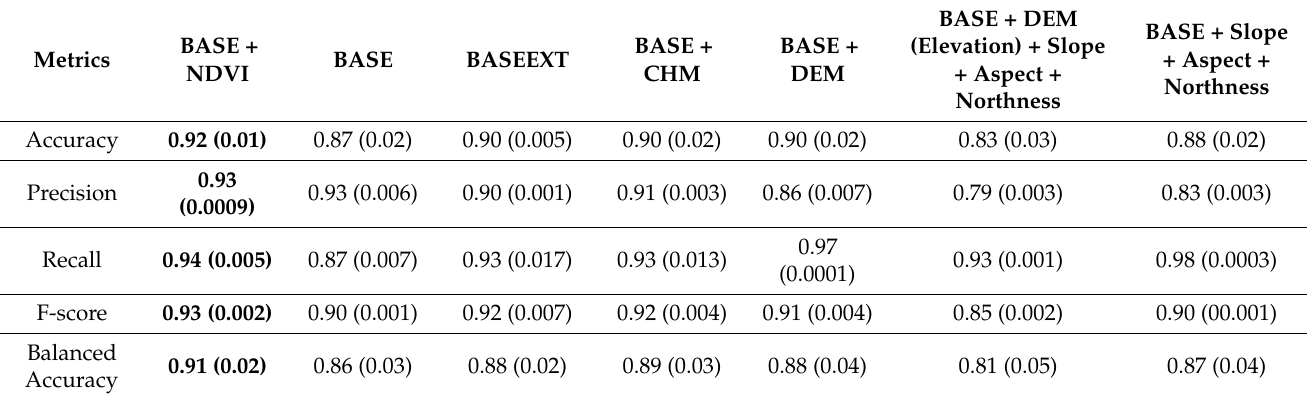
Table A3. Performance metrics in Engadin, Switzerland 1 .